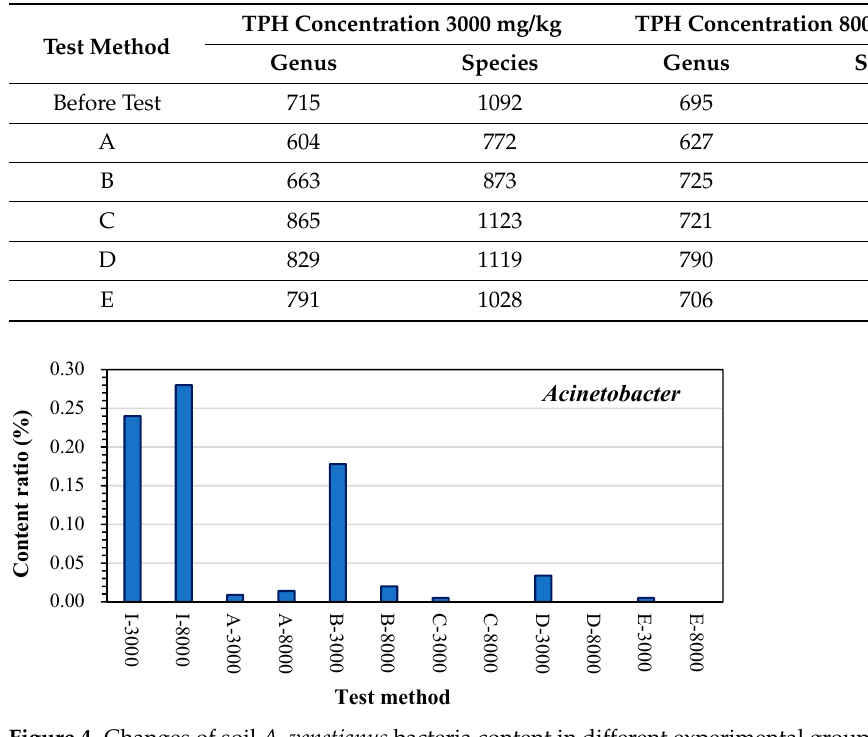
Figure 4. Changes of soil A. venetianus bacteria content in different experimental groups before and after the experiment. “3000” and “8000” stand for the soil TPH concentration were 3000 mg/kg and 8000 mg/kg respectively. “I” stands for the sample before testing; “A”: used the native bacteria; “B”: added the petroleum-decomposing bacteria; “C”: planted V. zizanioides; “D”: added A. venetianus bacteria and planted V. zizanioides; “E”: 2.5% biochar was added to the soil and planted V. zizanioides.